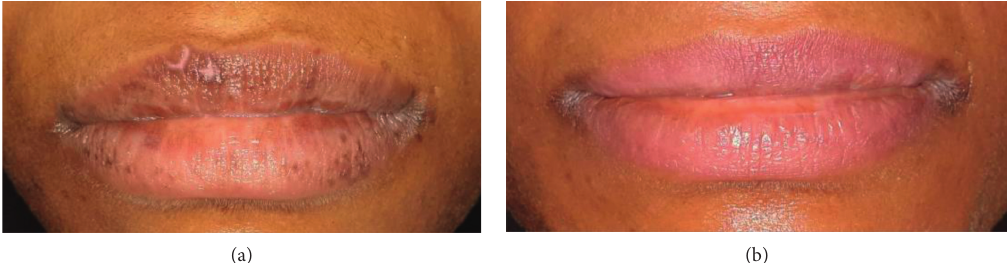
Figure 14: Upper and lower lips hyperpigmentation and scars due to a previous attempt as the patient claimed. (a) Before and (b) after the scars correction.